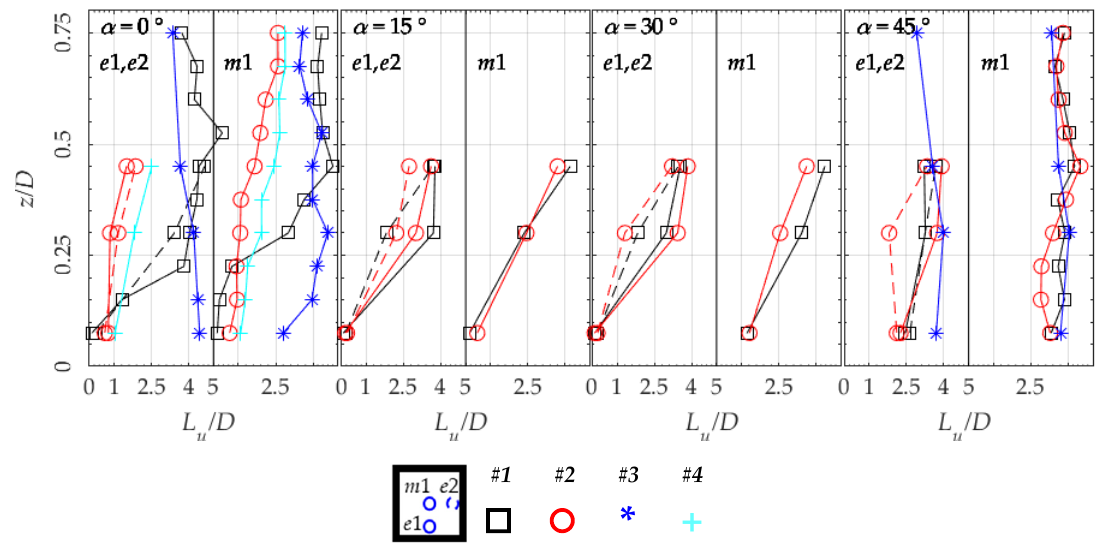
Figure 14. Longitudinal integral length scale of turbulence L u at windward and leeward edges ( e 1, e 2) and centre locations ( m 1). Symbols as indicated in the legend, for the four wind directions and configurations.